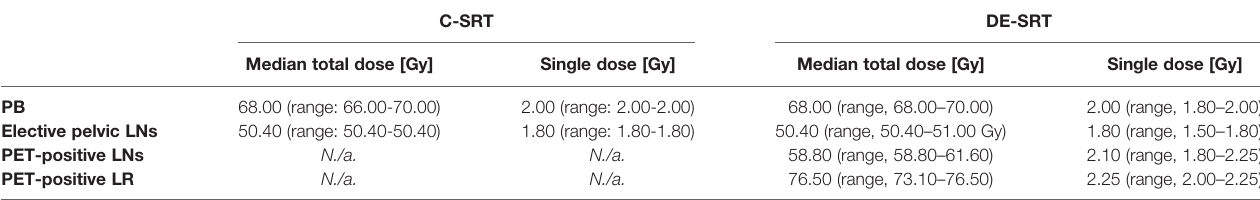
TABLE 2 | Radiation doses for conventional salvage radiotherapy (C-SRT) and dose-escalated salvage radiotherapy (DE-SRT).